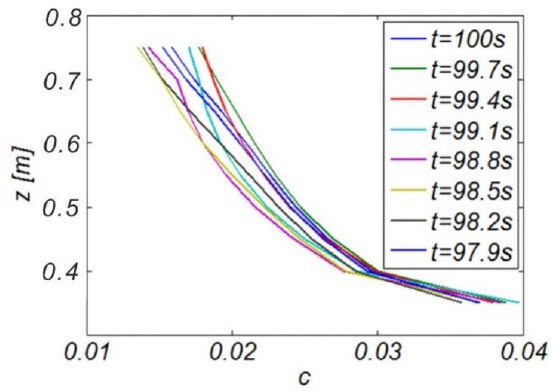
Figure 11. Temporal variation of vertical profile of the suspended sediment concentration [Run